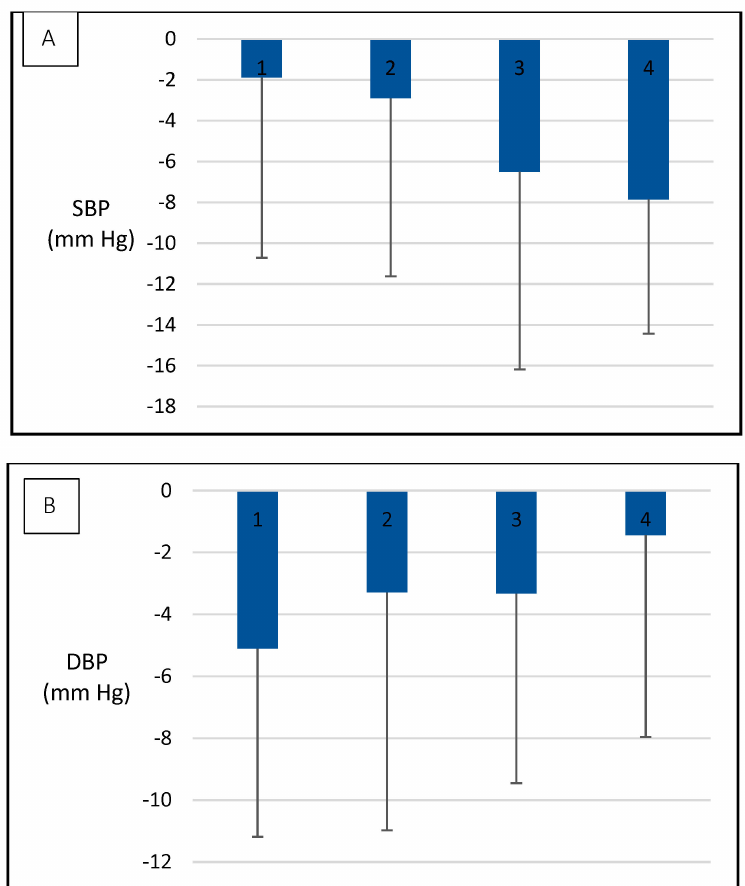
Figure 4. Association between changes in SBP (Figure 3A) and DBP (Figure 3B) and changes in VO 2 max over a one-year lifestyle intervention. Groups 1 to 4 represent the distribution of participants according to the difference in VO 2 max between T0 and T12. 1, loss between 0.1 and 3 mLO 2 /kg/min ( n = 8); 2, gain between 0 and 2.9 mLO 2 /kg/min ( n = 50); 3, gain between 3 and 5.9 mLO 2 /kg/min ( n = 29); and 4, gain between 6 and 8.9 mLO 2 /kg/min. Table 3. Comparison of the cardiometabolic profile and variations over time between adverse responders ( n = 12) in blood pressure and other participants ( n = 89).